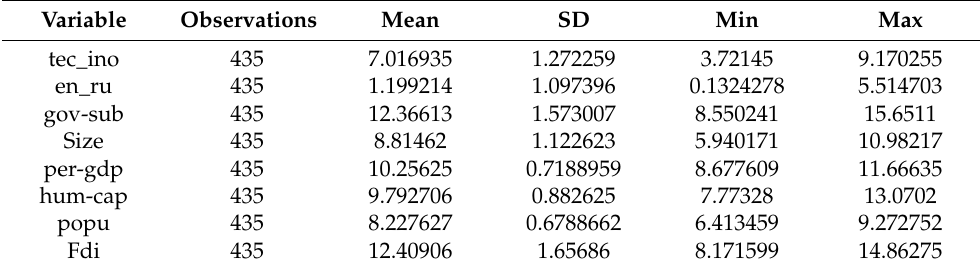
Table 3. Descriptive statistics of the variables (after logarithm).